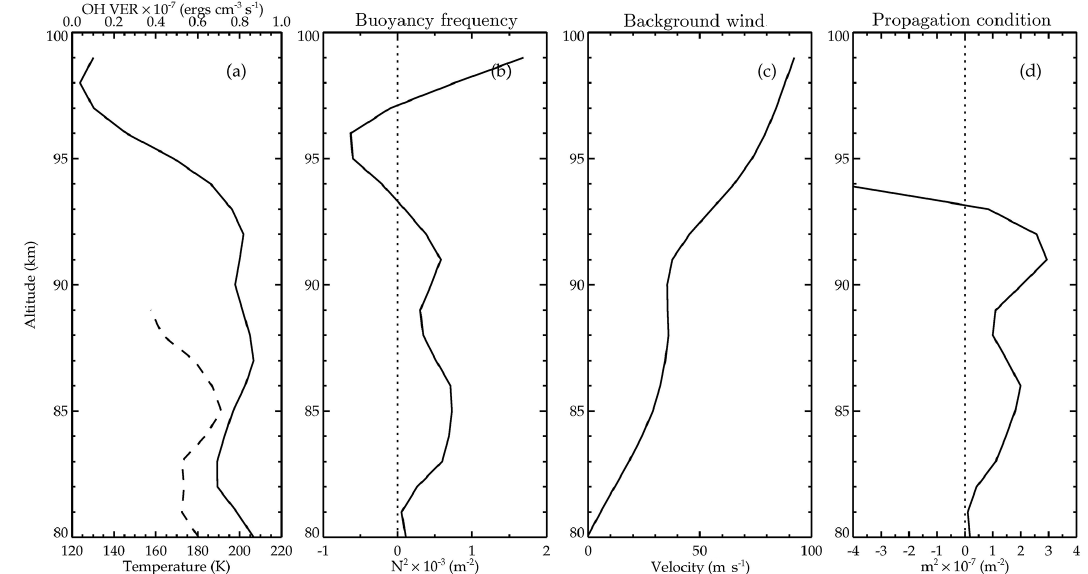
Figure 6. Same as Fig. 5 but for the mesospheric front observed on 23 August